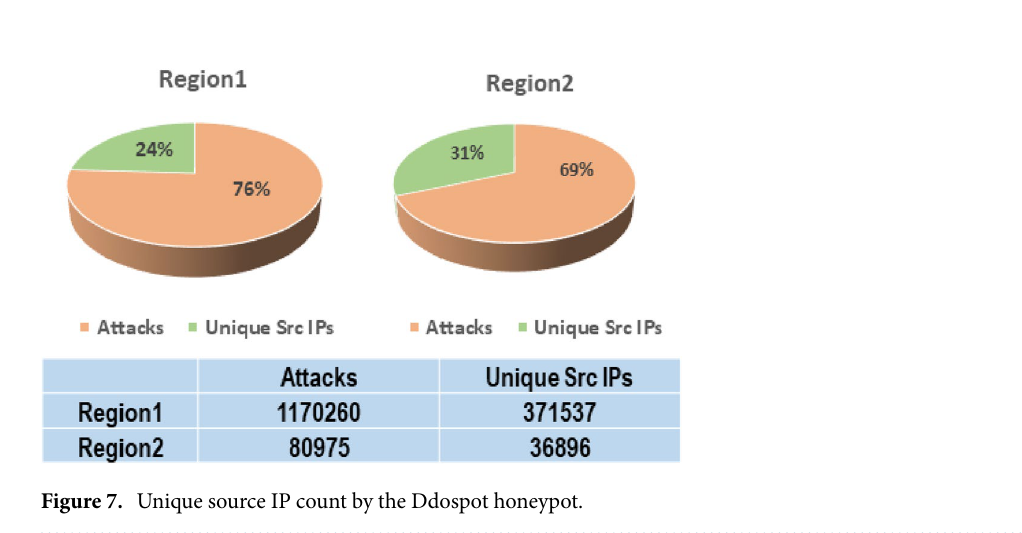
Figure 6. Commands executed by the adversaries upon access for launching busybox and trinity botnet attacks.